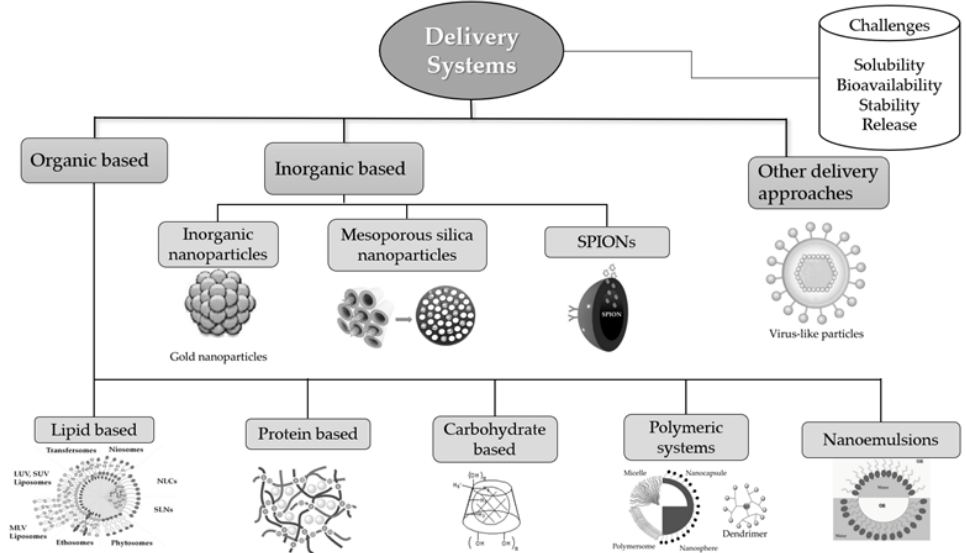
Figure 2. Types of carriers for the delivery of phytochemicals (abbreviations: SPIONs, superparamagnetic iron oxide nanoparticles; MLV, multilamellar vesicles; LUV, large unilamellar vesicles; SUV, small unilamellar vesicles; NLC, nanostructured lipid carriers; SLN, solid lipid nanoparticles).